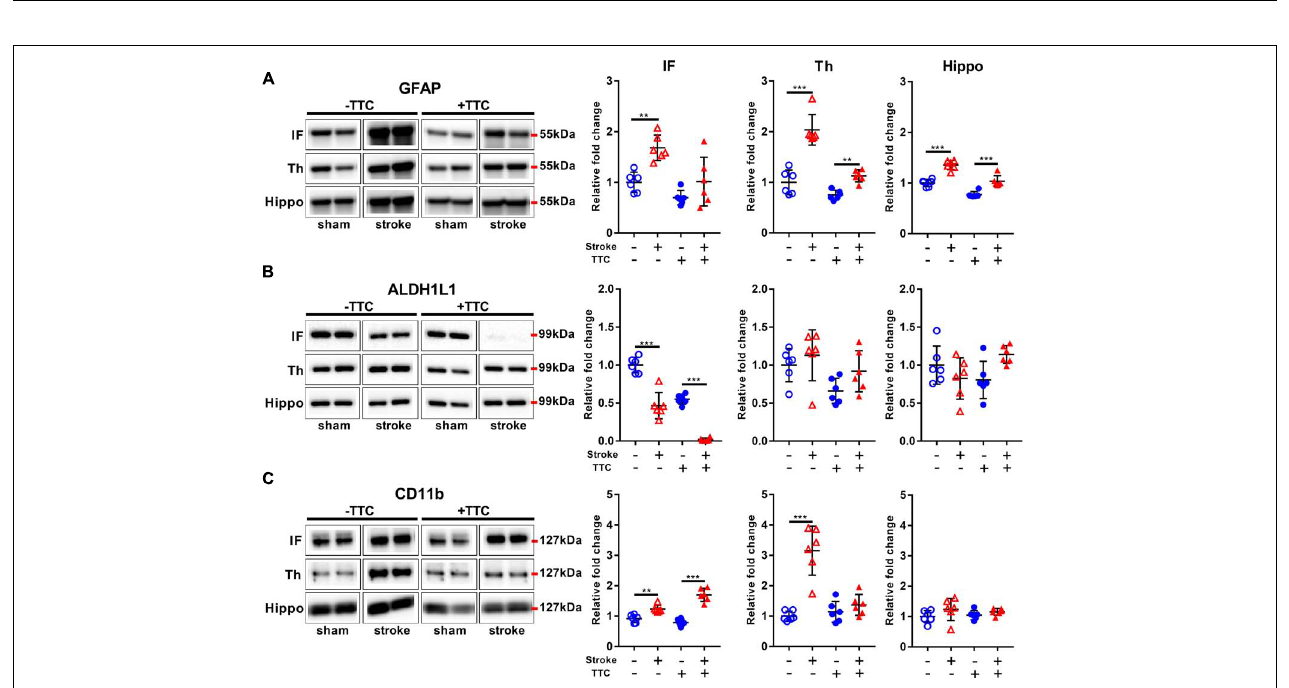
FIGURE 4 | Glial markers. Representative western blot and quantification of GFAP (A) , ALDH1L1 (B) , and CD11b (C) within the infarct (IF), thalamus (Th), and hippocampus (Hippo). Mean ± SEM (two-way ANOVA and Sidak’s multiple